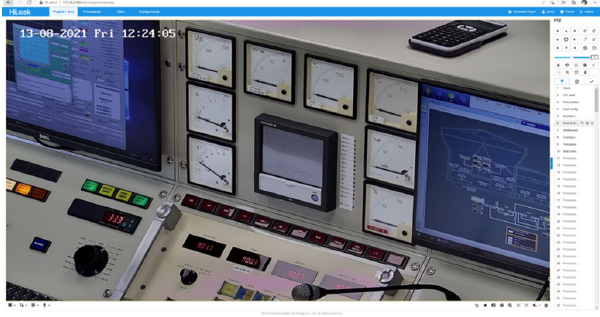
Figure 1 Dome camera pointed to the nuclear instrumentation. It could be remotely moved and zoomed-in to any point in the control room by using controls on the top right corner. Predefined